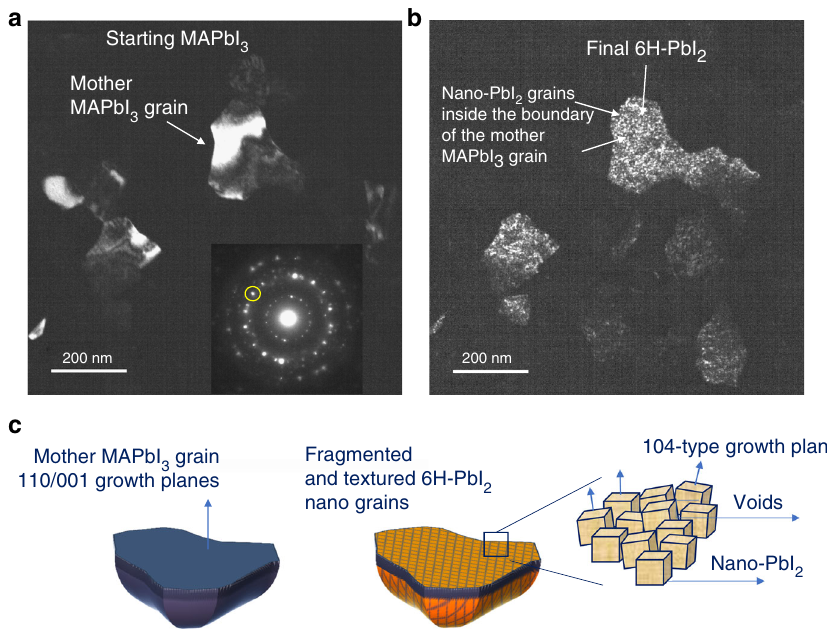
Fig. 4 Fragmentation of the starting large MAPbI 3 grains into nano-grains of PbI 2 .The starting layer thickness is 40 nm. a Fresh sample image taken in dark fi eld (DF) by selecting the area of the EDP indicated in the inset by the yellow circle. b DF taken in the same region as in a with the aperture of the slit unchanged (see inset in a) after ~ 820 s (transition end). c Representation of the lattice alignment between MAPbI 3 and PbI 2 during transition at the grain core: it is highlighted that the growing planes (104 or the equivalent 1-14/014 are the same for all the nano-grains nucleated inside the boundary of a shared perovskite mother grain apart from a slight spread of their direction (represented by the vectors over the single grains in the right side schematic). The images are representative of the phenomenon all over the sampled